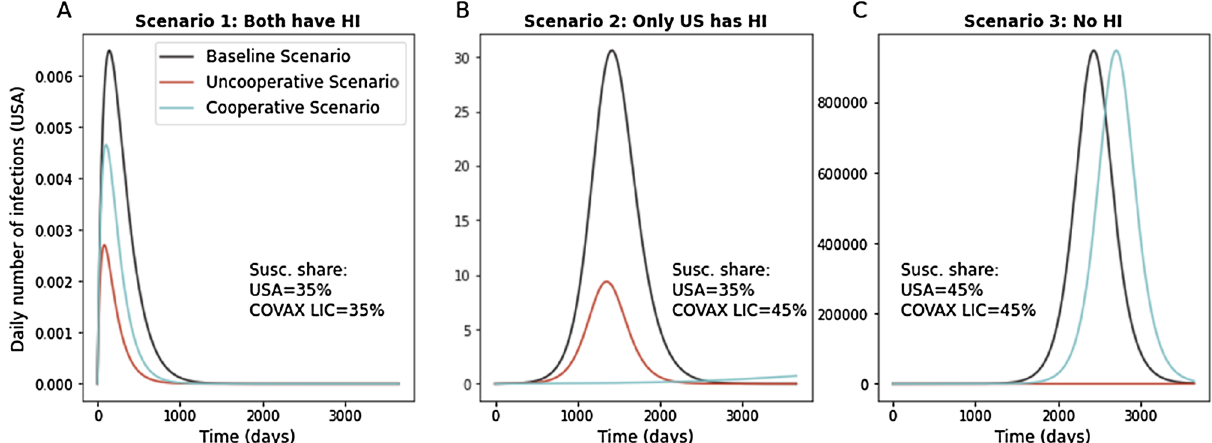
Figure 2. Daily number of infections in the US, comparison between Uncooperative and Cooperative scenarios. The figure compares between distributing 60mln extra doses in the USA (uncooperative scenario: red line) or in COVAX-LIC (cooperative scenario: light blue). In the baseline scenario (black line) the extra doses are not distributed. All panels consider R 0 = 2.5 and the initial share of susceptible in the rest of the world equal to 35%. ( A ) The figure shows the daily number of infections in the US as estimated by the SIR model, when at time 0 the number of infected individuals equals 1000 in COVAX-LIC and is 0 everywhere else. The share of susceptible is 35% in both the US and in the COVAX-LIC. ( B ) As ( A ), but with initial shares of susceptible equal to 35% in the US and 45% in COVAX-LIC. (C) As ( A ), but with initial shares of susceptible equal to 45% in the US and 45% in